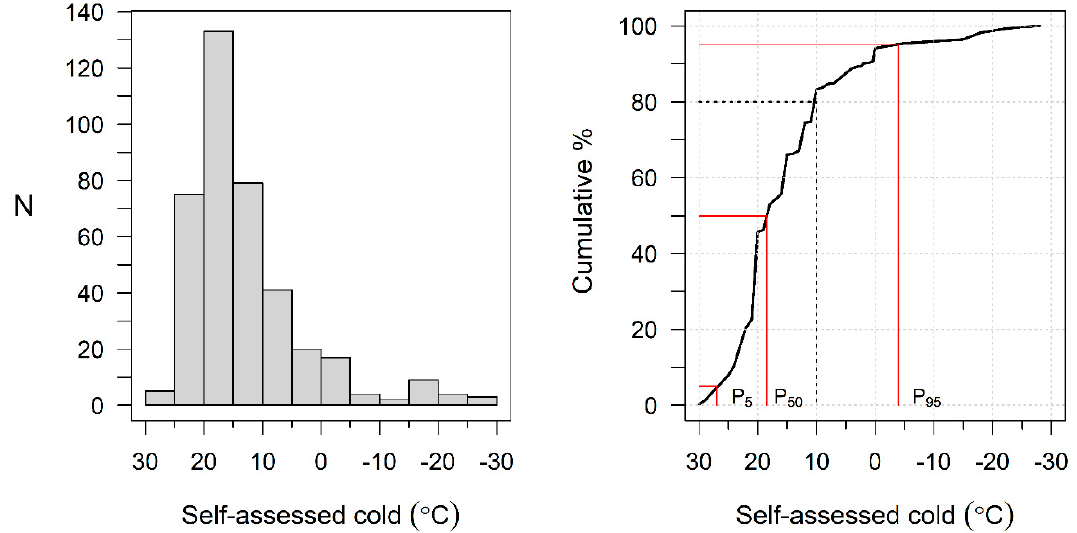
Figure 1. Histogram and cumulative distribution of self-assessed cold temperature. Dotted line indicates the ISO-defined threshold for workplace cold (10°C).